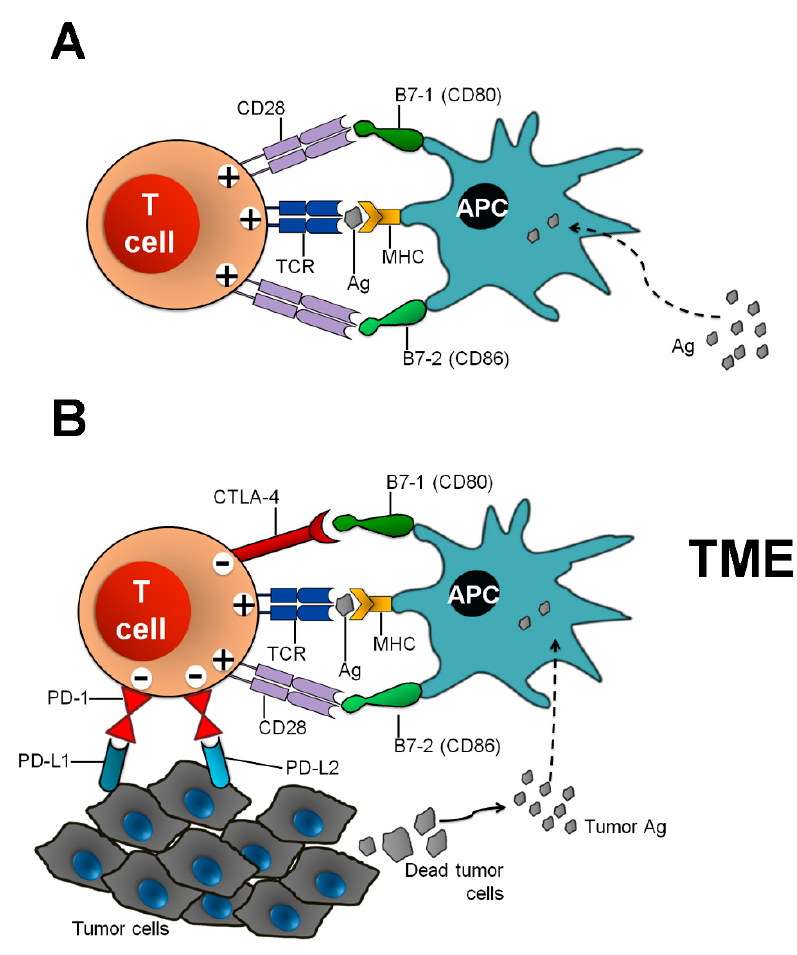
Figure 1. ( A ) T cell activation and CTLA-4 and PD-1 checkpoints in the regulation of antitumor T cell